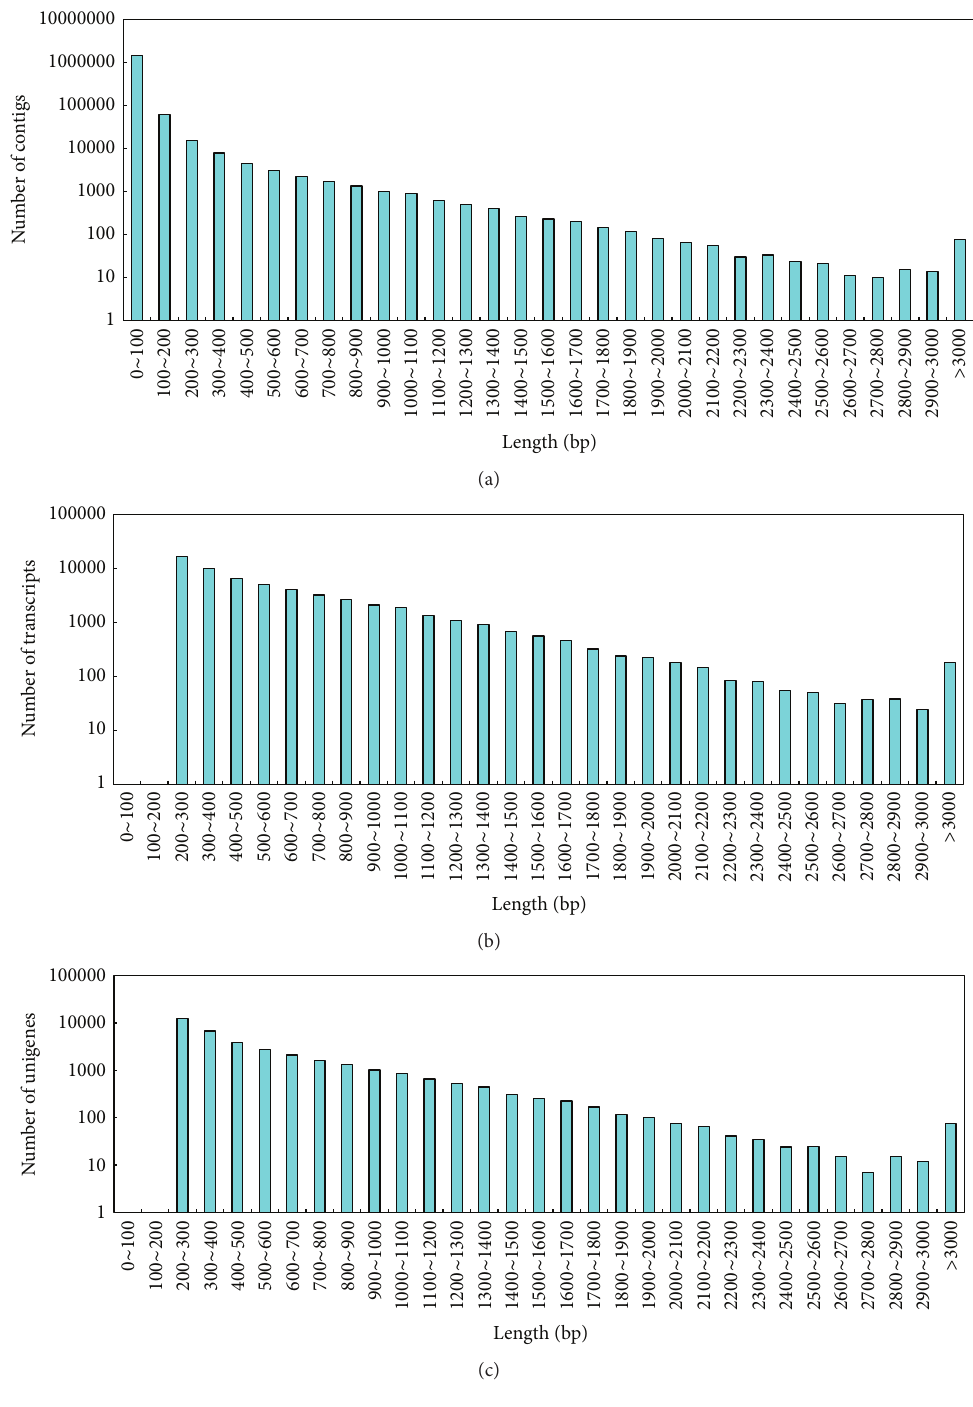
Figure 1: Overview of the sweet potato transcriptome assembly. (a) Size distribution of contigs; (b) size distribution of transcripts; and (c) size distribution of